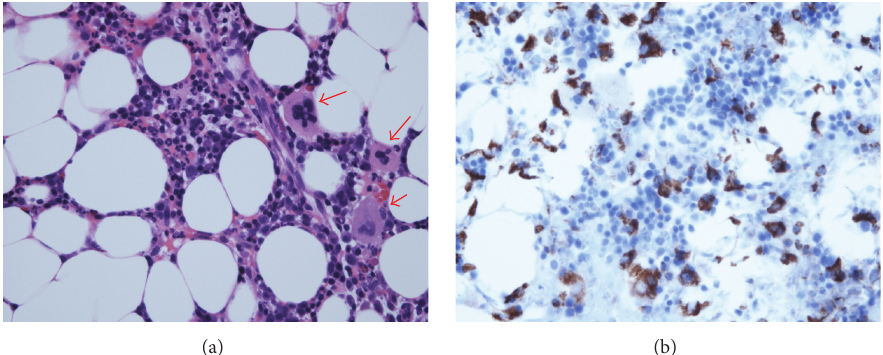
Figure 2: (a) The phagocytic reticular cells (arrows). The phagocytosis of mature neutrophils by phagocytic reticular cells is present. Hematoxylinandeosin(HE)staining.(b)Immunohistochemistryshowingmonocyteinfiltrationsinbonemarrow.TheCD68 + cellsincreased and were diffusely distributed in stroma of bone marrow. Immunohistochemical staining using antibodies against